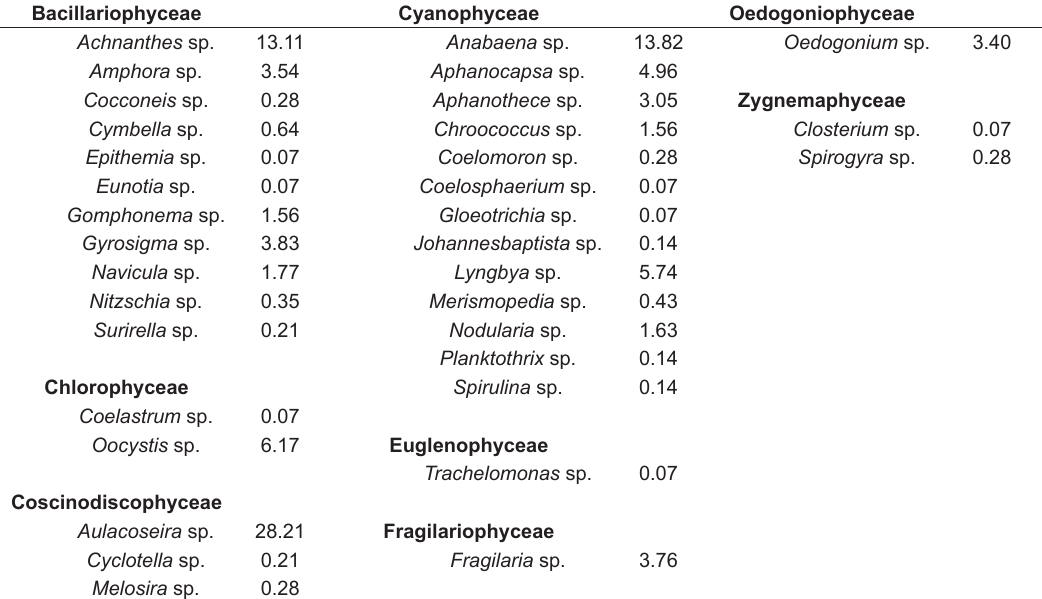
Table 5. Proportional abundance of microalgae genera observed in the stomach contents of O. niloticus during the study period